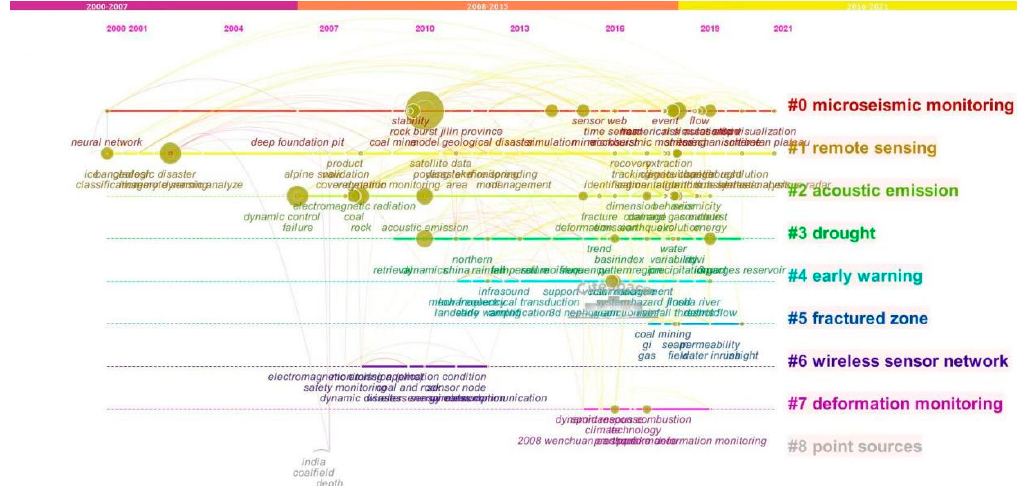
Figure 3. The knowledge map of China’s dynamic disaster monitoring and early warning interna- tional research hotspots (2000–2021) (timeline type).